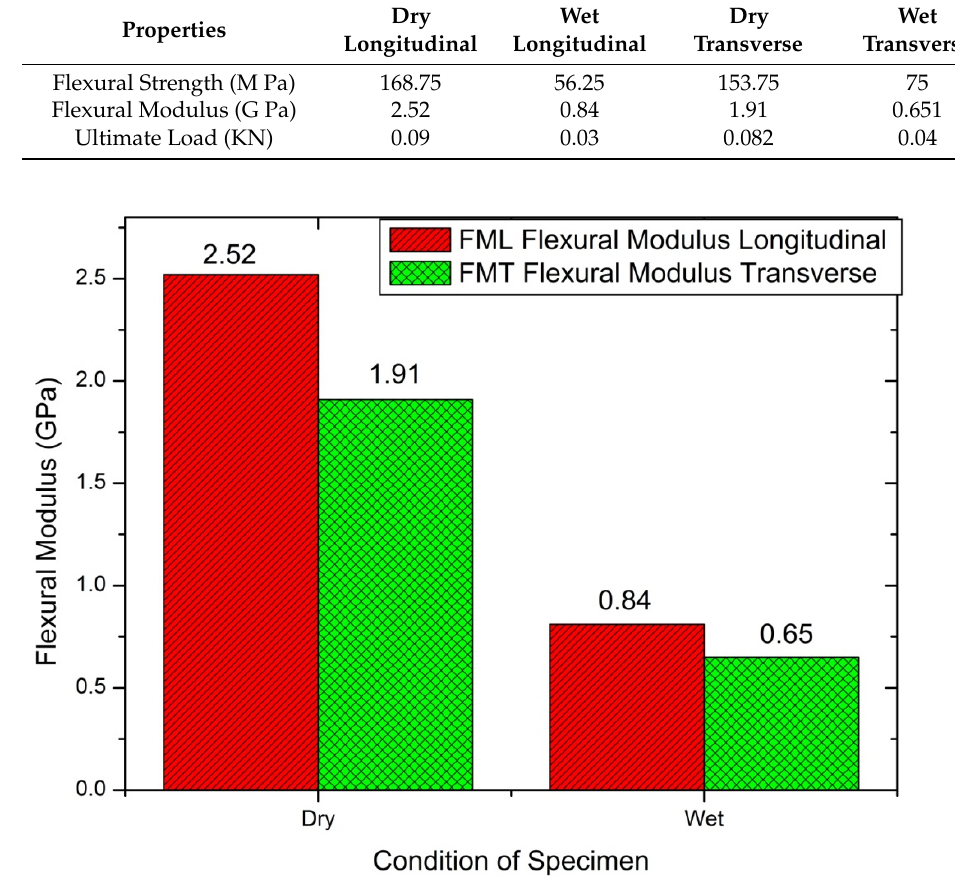
Figure 8. Flexural modulus determined by the three-point method for dry and wet condition in the longitudinal and transverse directions.